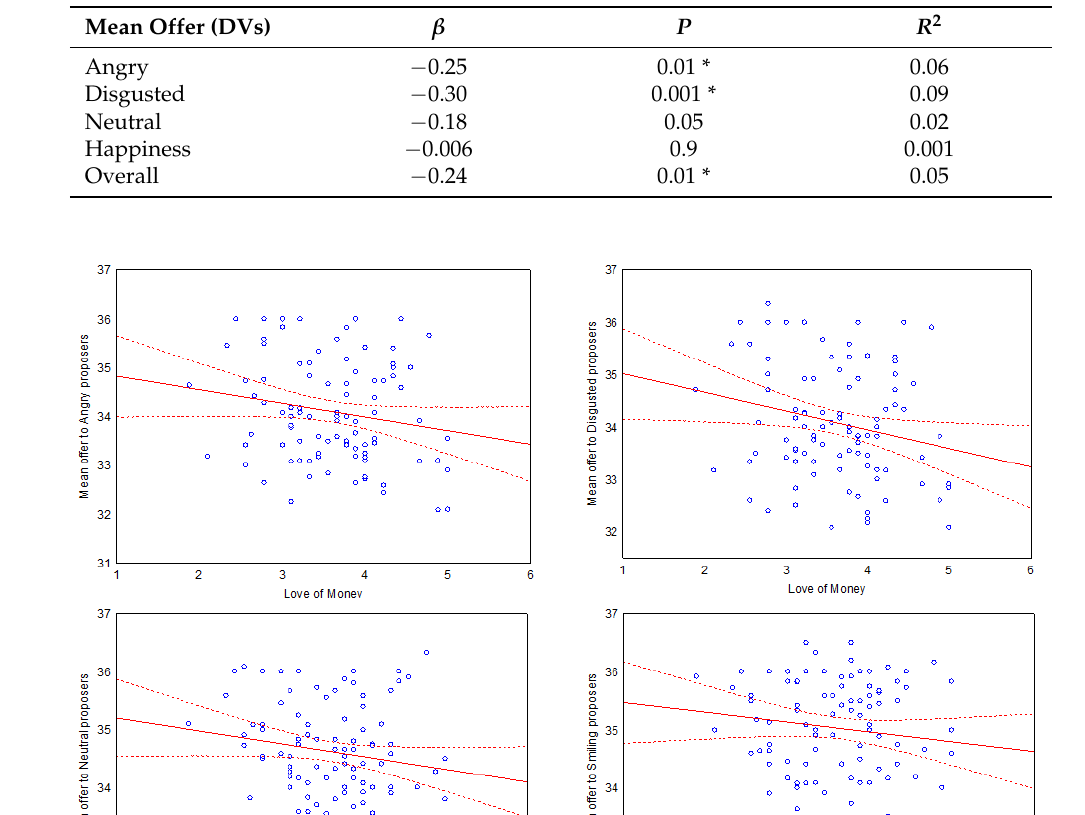
Table 4. Regression results: Age as a continuous predictor and angry, disgusted, neutral, happiness and overall average offer as DVs.